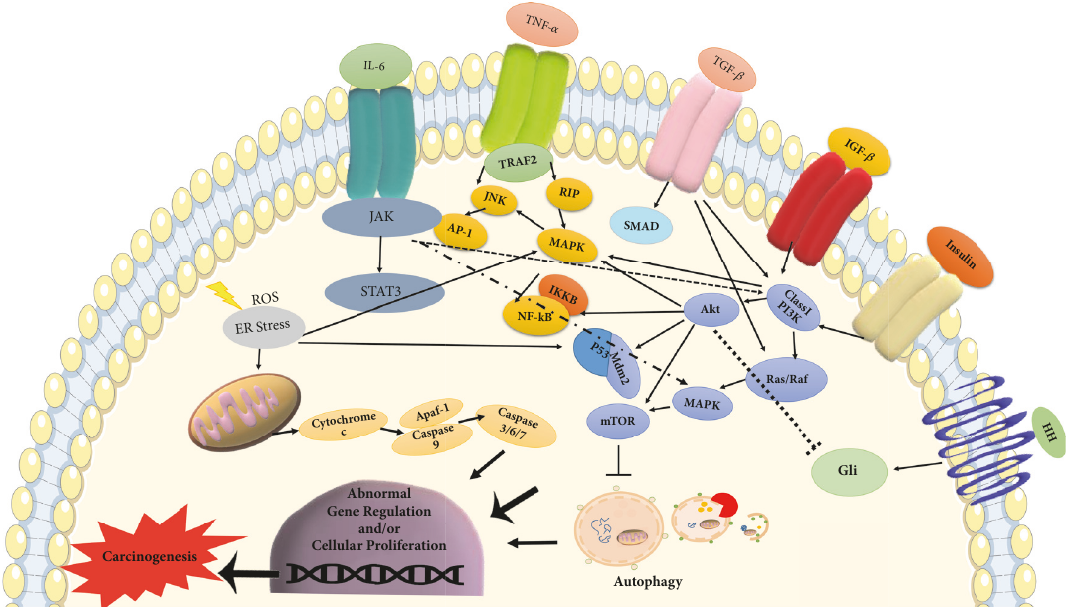
Figure 4: Interaction of oncogenic pathways in NASH-HCC